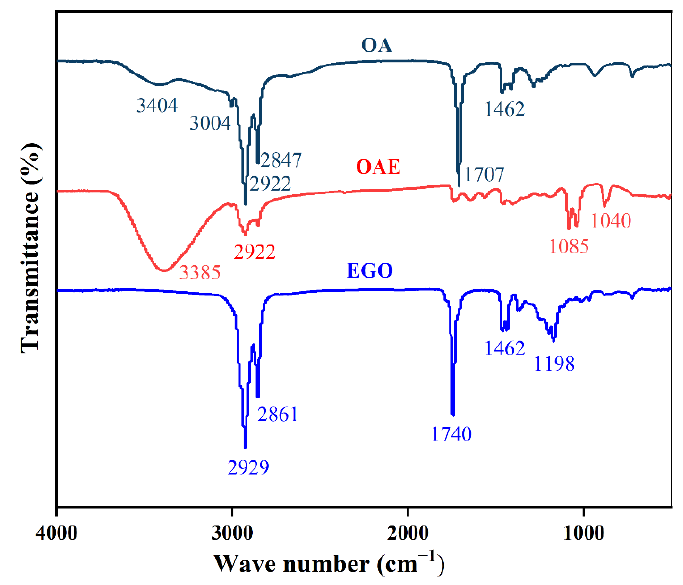
Figure 10. FT-IR of oleic acid and oleate.